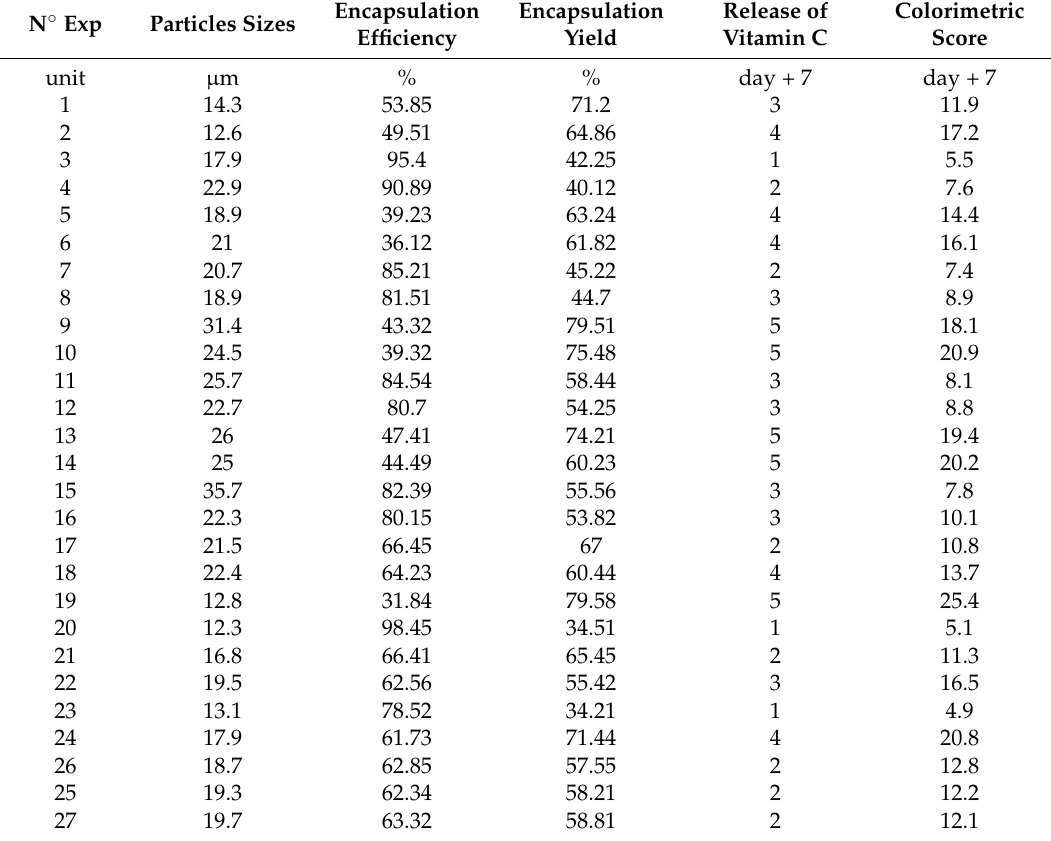
Table 2. Experimental